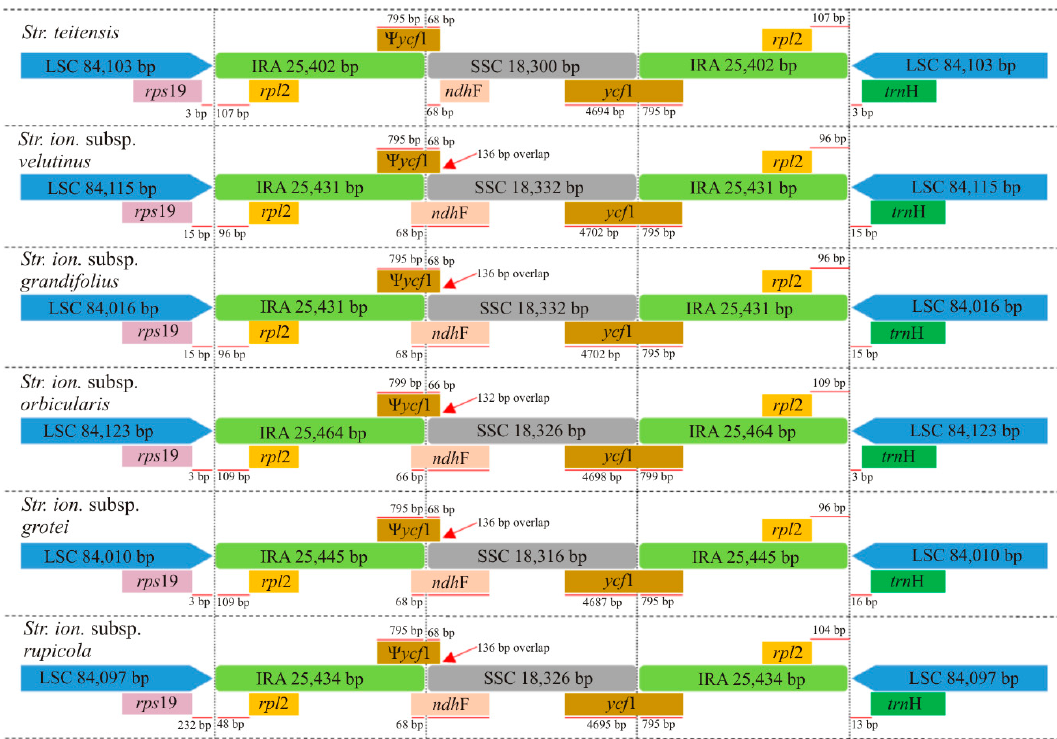
Figure 3. Comparison of the Inverted Repeat/ Single Copy (IR/SC) junctions’ characteristics among the six sect. Saintpaulia genomes. The genes below and above are transcribed in clockwise and counter-clockwise directions, respectively. The setting is not to scale.